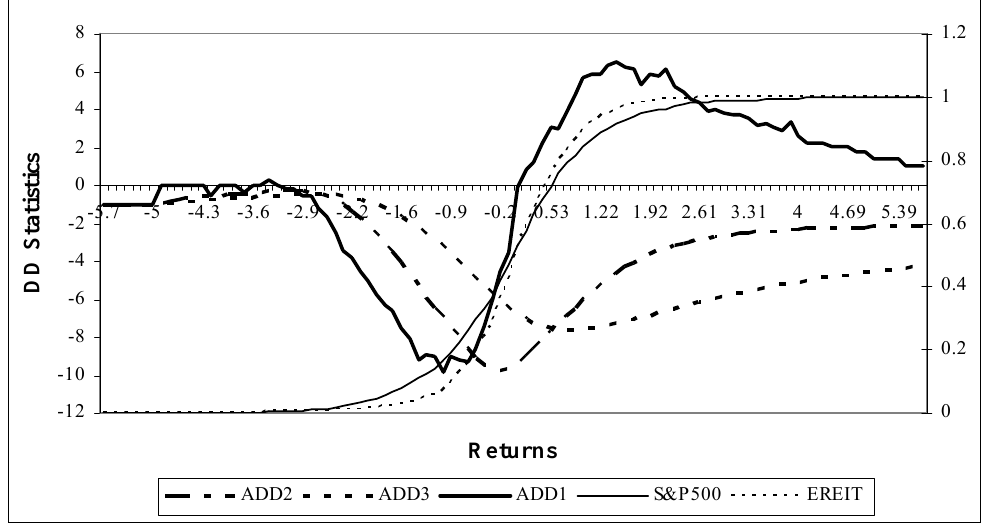
Figure 1: CDF and DD Statistics Between Equity REITs and the S&P 500 for Risk-Averters -12-10-8-6-4-202468 -5.7